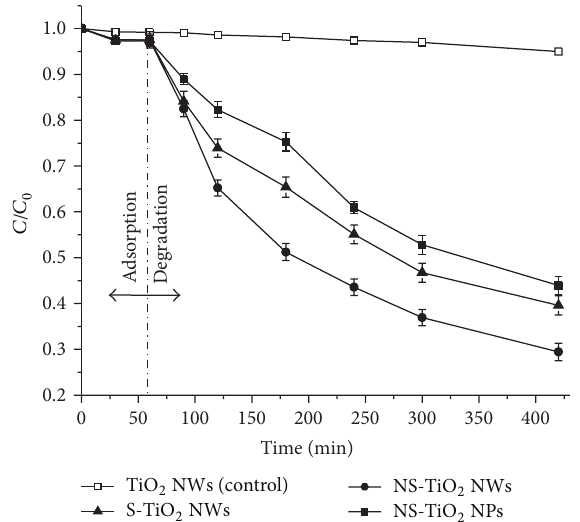
Figure 6: Photocatalytic degradation of atrazine irradiated by visible light.